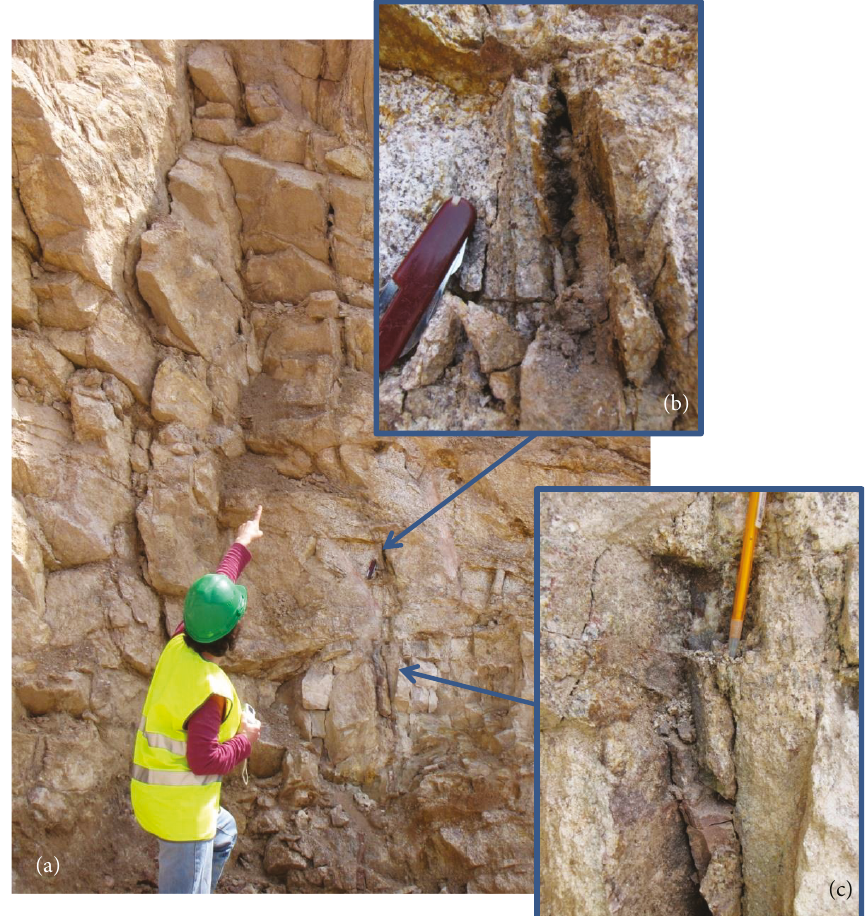
Figure 2: Example of fracture in granite (a) with quartz fi lling (b) and alteration halo (c) (Ottenhö ff en quarry, Germany).